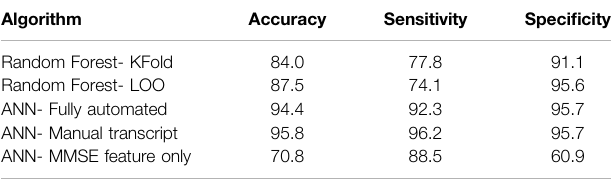
TABLE 5 | Final Accuracy, Sensitivity, and Speci fi city (%) of Different ML Models.